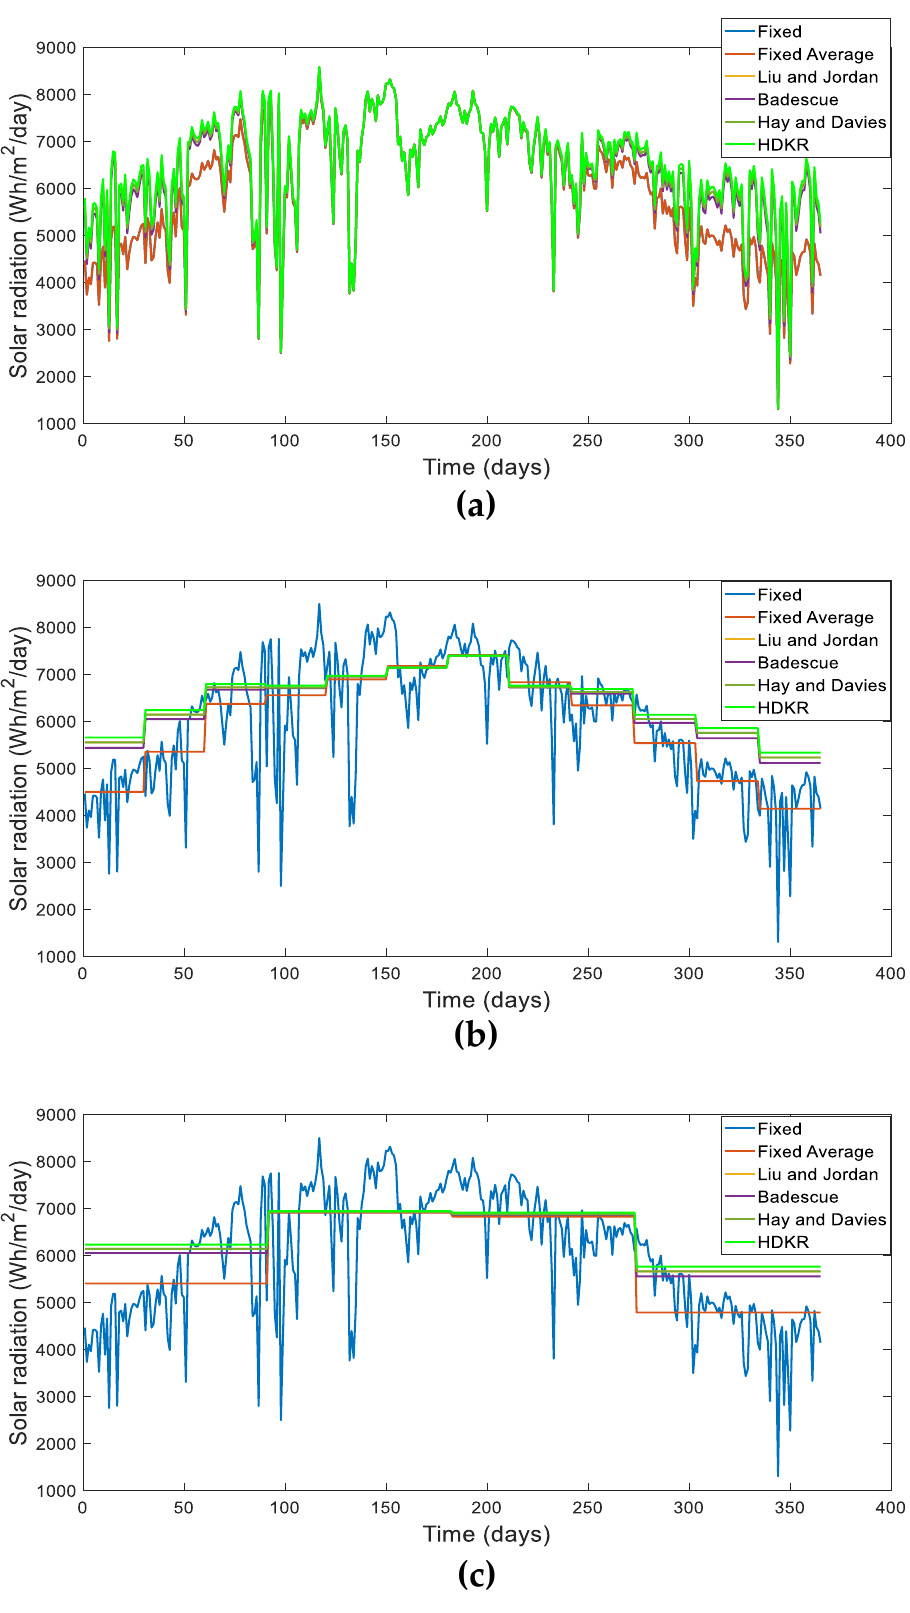
Figure 9. Comparison of the total solar radiation radiated by a horizontal versus a tilted surface for optimized tilt angle adjustment for Makkah city over different periods: ( a ) NP = 365, ( b ) NP = 12, ( c ) NP = 4.